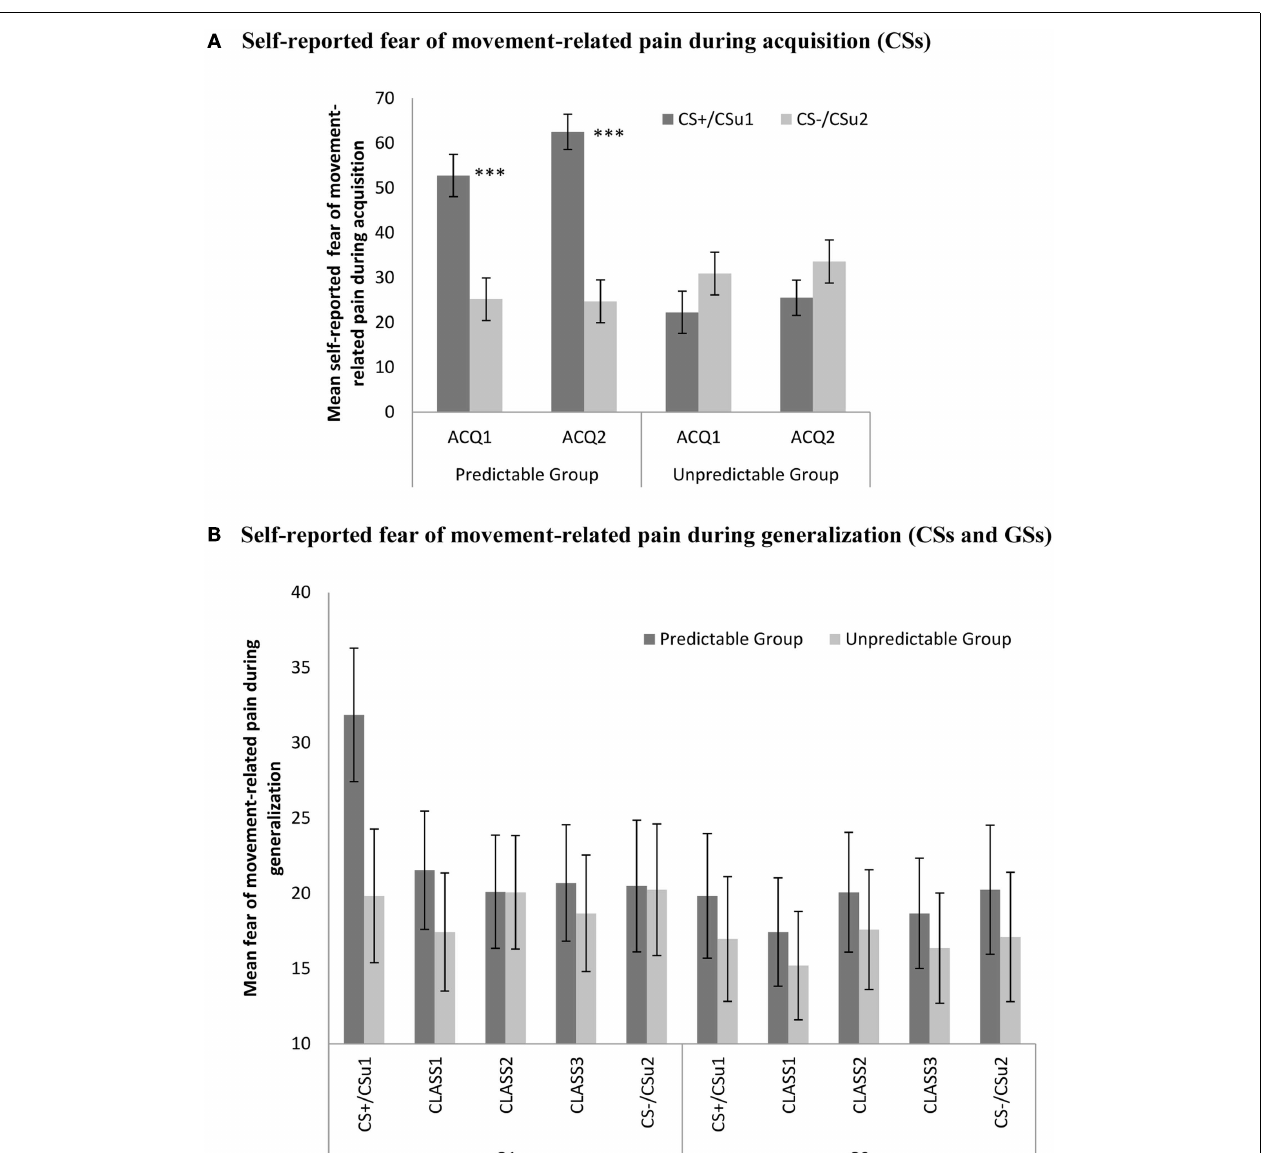
of GS movements (CLASS1–3) in the predictable and the unpredictable group during the generalization blocks (G1–G2). (A) Self-reported fear of movement-related pain during acquisition (CSs). (B) Self-reported fear of movement-related pain during generalization (CSs and